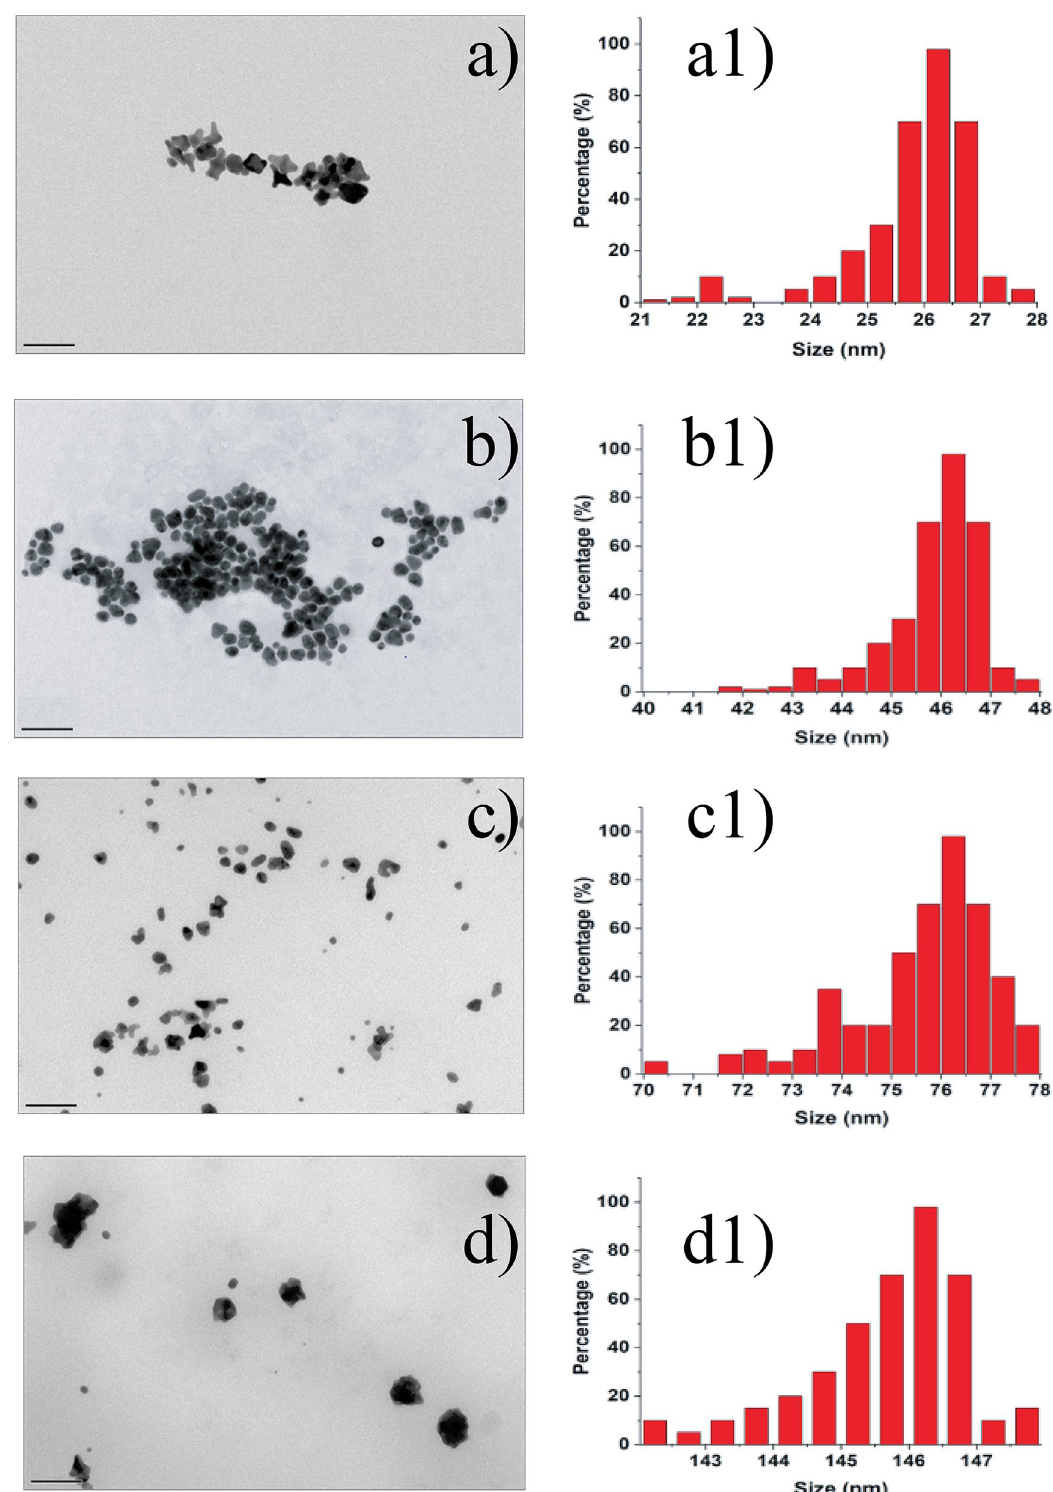
Figure 3. Nanoparticle morphology. TEM images and size distribution of gold nanoparticles produced with HEPES ( a – a1 ), MnSOD ( b – b1 ), CAT ( c – c1 ) and BSA ( d – d1 ). The scale bar corresponds to 50 nm on each